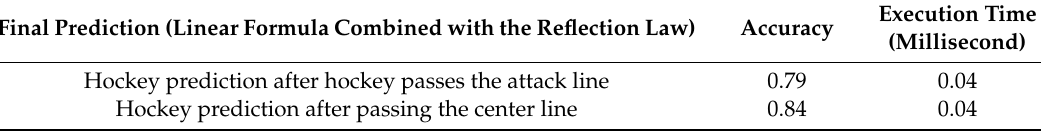
Table 6. Prediction accuracy and execution time in method 2.